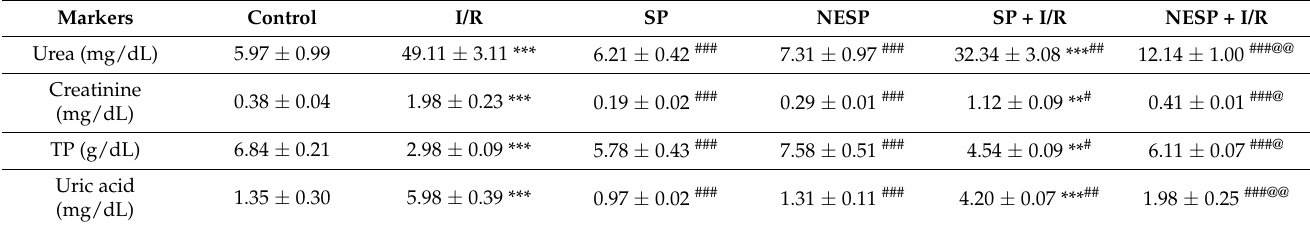
Table 1. Effects of administration of spironolactone (SP) and nano-encapsulated spironolactone (NESP) on the serum levels of urea, creatinine, total protein (TP) and uric acid in control, ischemic/reperfusion (I/R), spironolactone (SP), nano- encapsulated spironolactone (NESP), spironolactone-treated I/R (SP + I/R) and NESP-treated I/R (NESP + I/R) groups at the end of intervention ( n = 8). The data are represented as mean ± SD. Asterisks indicate significant difference compared to control group (** p < 0.01 and *** p < 0.001, analysis of variance (ANOVA), Tukey’s test for post-hoc comparisons). Hash marks indicate significant difference compared to I/R group ( # p < 0.05, ## p < 0.01 and ### p < 0.001, ANOVA, Tukey’s test for post-hoc comparisons). @ symbols show significant differences between SP + I/R and NESP + I/R groups ( @ p < 0.05 and @@ p < 0.01, ANOVA, Tukey’s test for post-hoc comparisons).